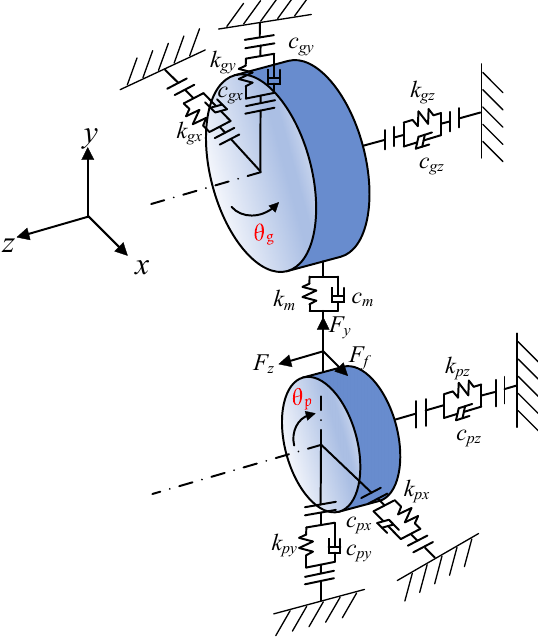
Figure 11. Schematic diagram of gear dynamic model.